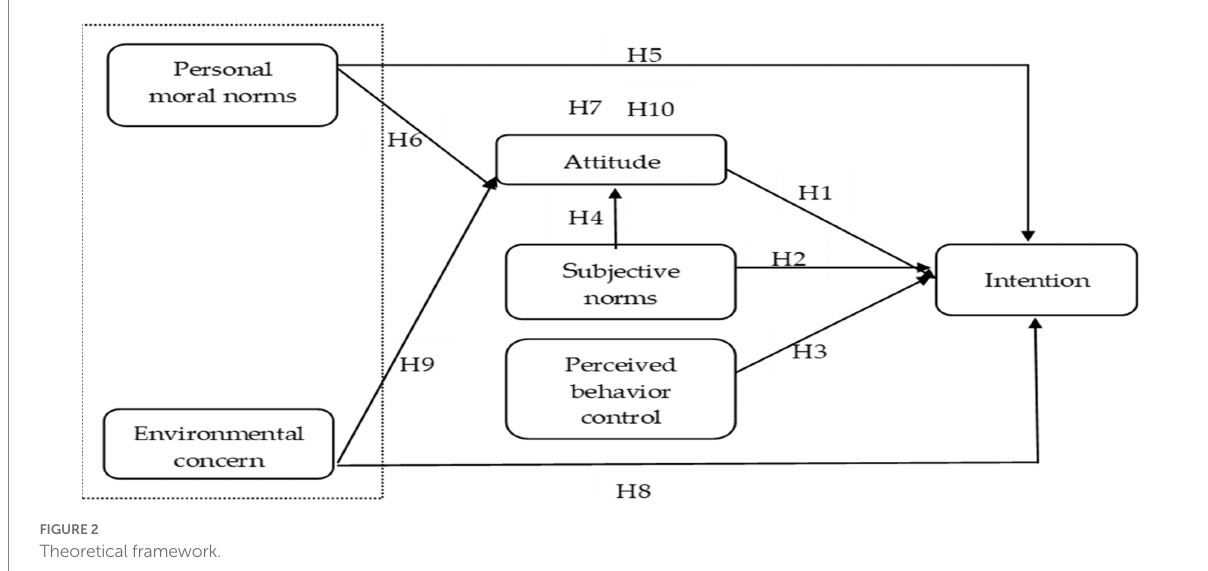
FIGURE 2 Theoretical